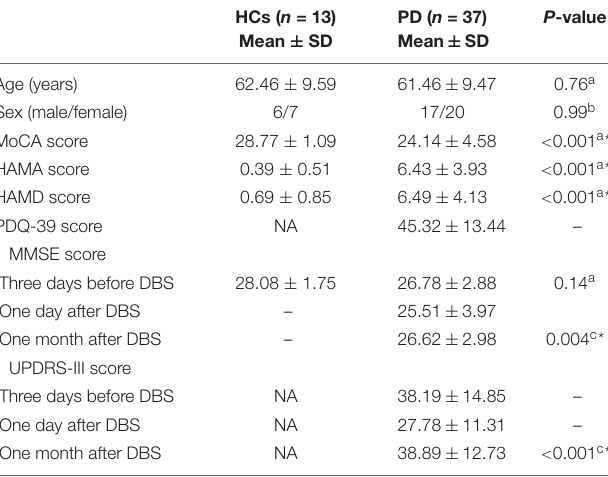
TABLE 1 | Demographic and clinical data of all